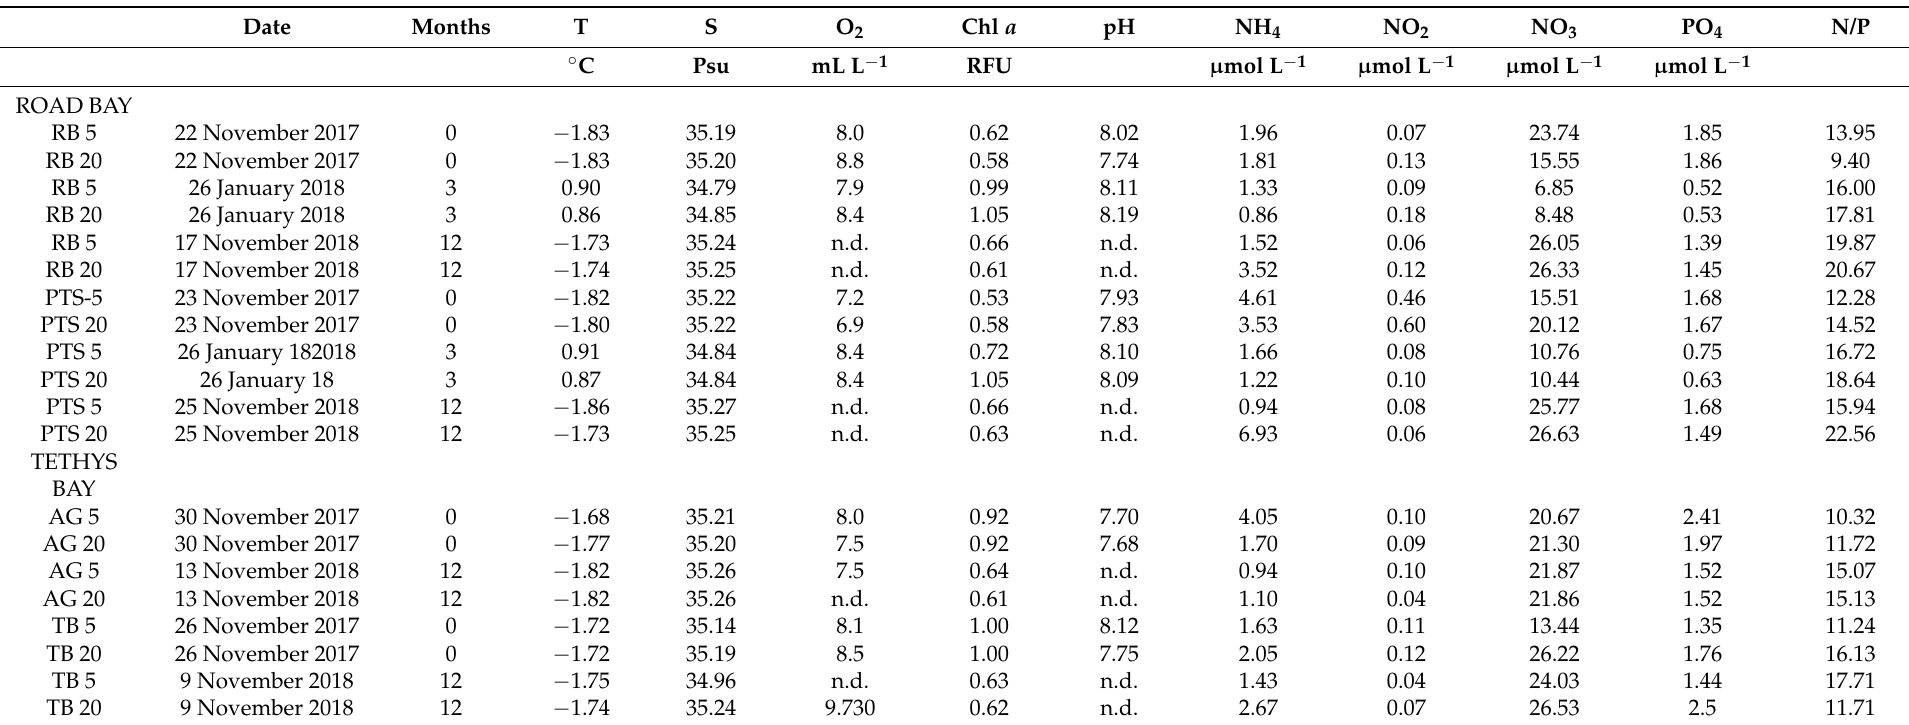
Table 2. Physico-chemical parameters measured in Road and Tethys Bays at initial time (Time 0) and after 3 (Time 3) and 12 months (Time 12) of the experiment (n.d., not